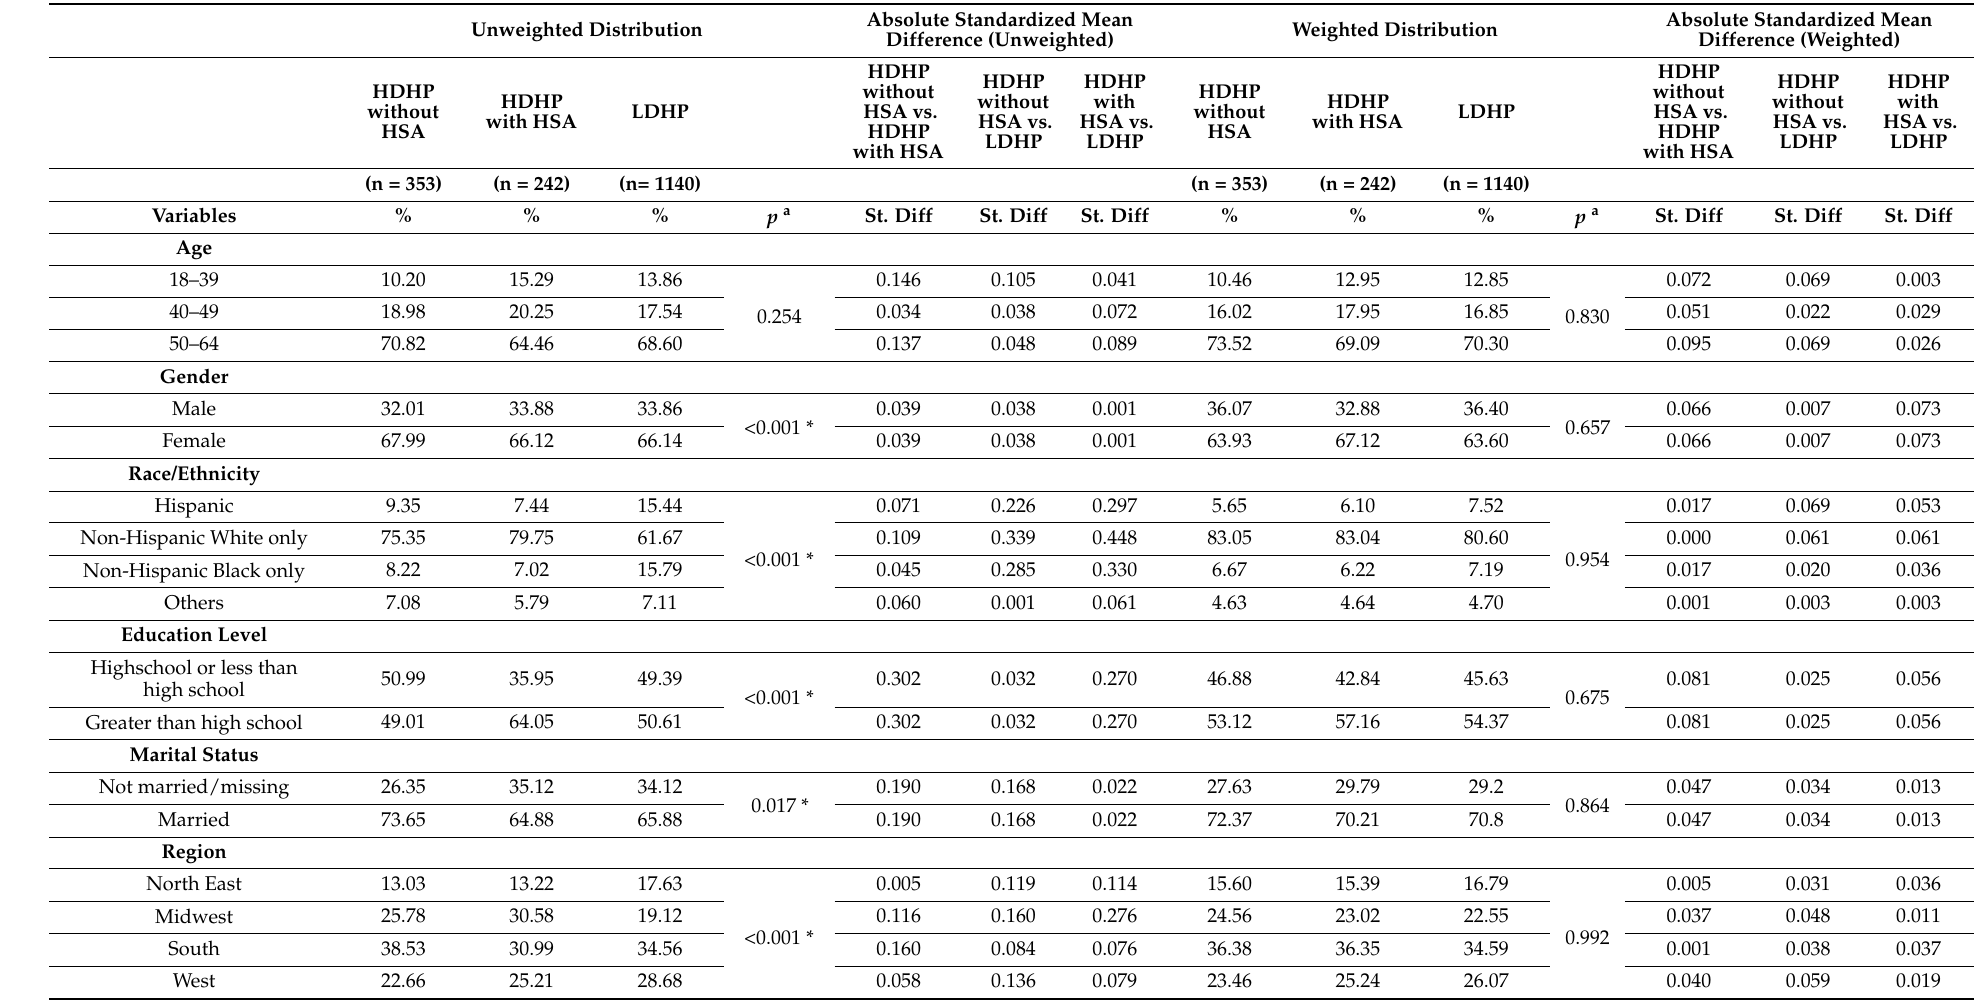
Table 1. Comparison of individual characteristics across groups before and after